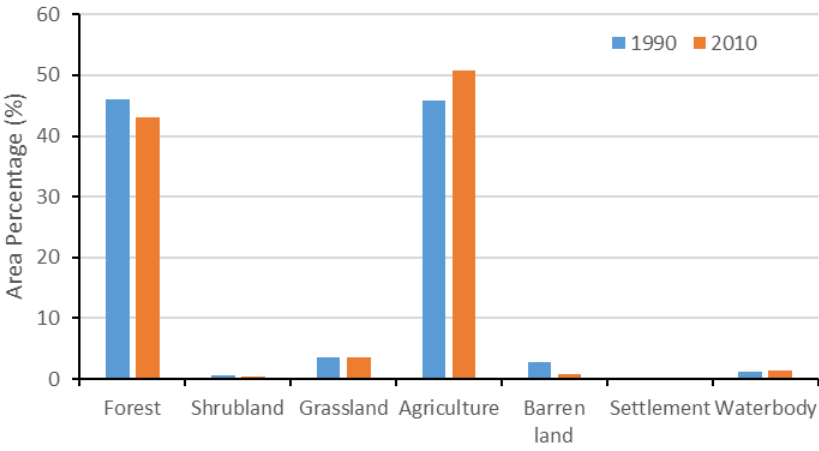
Figure 12. Evolutions in land cover in the basin from 1990 to 2010.